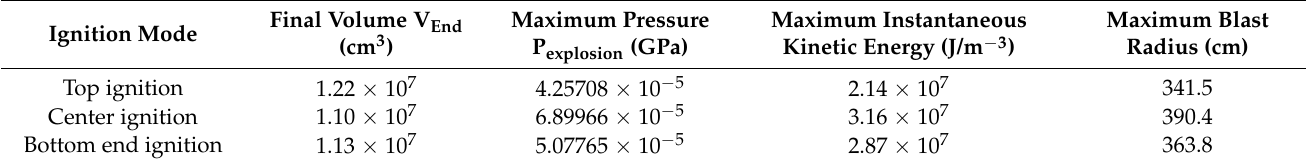
Table 5. Relationship between ignition position and ice blasting volume, final maximum pressure, and instantaneous kinetic energy.